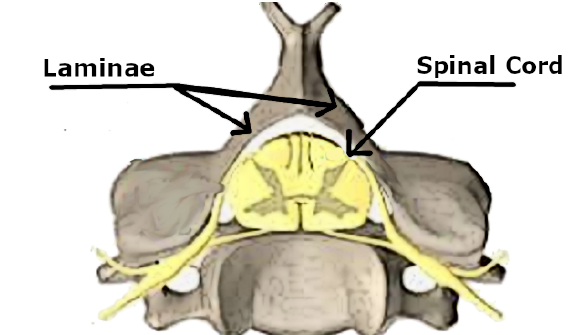
Figure 2. The spinal cord inside the vertebral column.